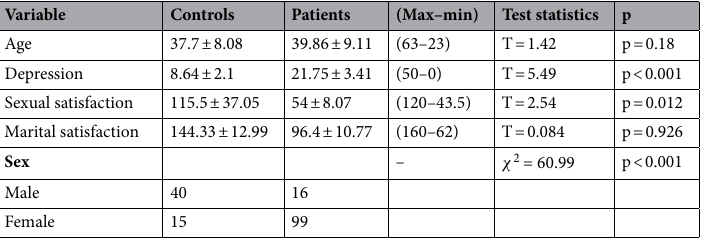
Table 1. Mean score of depression, sexual and marital satisfaction in patients and healthy controls.